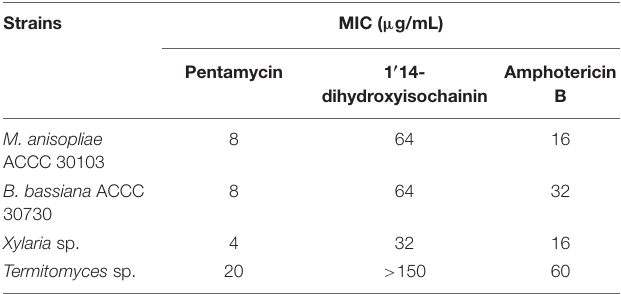
TABLE 2 | Minimal inhibitory concentrations (MIC, µ g/mL) of pentamycin and 1 (cid:48) 14-dihydroxyisochainin. Strains MIC ( µ